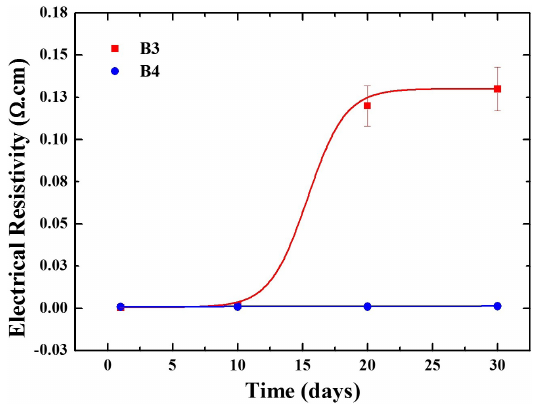
Figure 6. Electrical resistivity of the AZO films obtained using PMS as a function of ageing